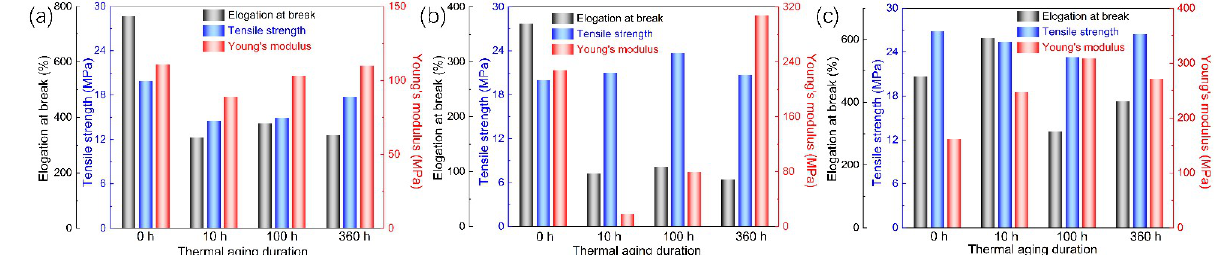
Figure 11. Tensile parameters of thermally aged PE samples. ( a ) LDPE, ( b ) FPE, and ( c )